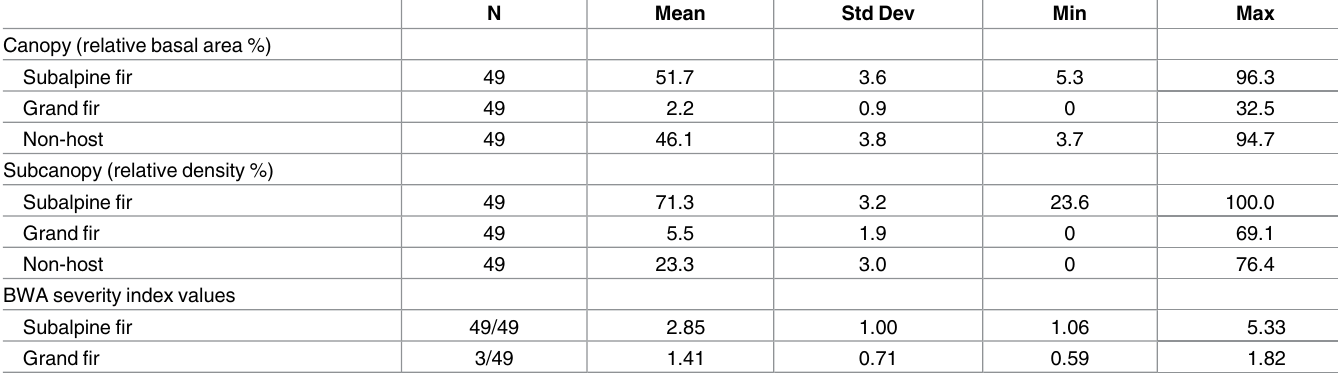
Table 1. Descriptivestatistics for stand composition and BWA severity in forty-nine sampling sites. Stand compositionis presented in relative val- ues (percentages of total) for basal area in the canopy ( (cid:21) 12.7cm DBH) and density in the subcanopy ( > 10cm height, < 12.7cm DBH), reported individually for each host species and a combinedvalue for all non-hosts. Severity index values are presented for each host species based on the number of sites in which they